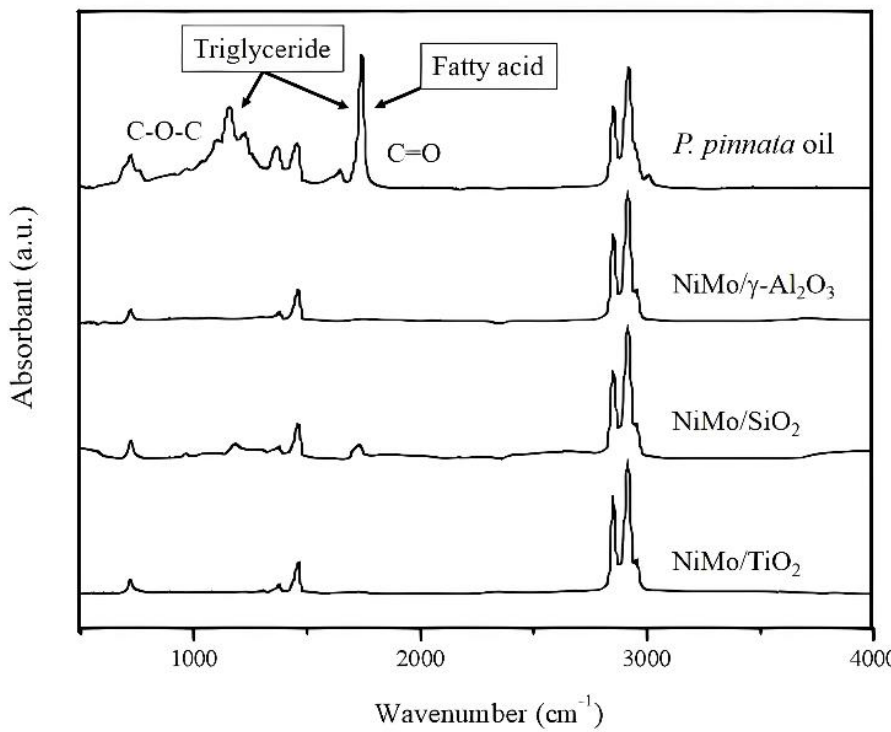
Figure 8. The FTIR spectra of Pongamia pinnata seed extracted oil and deoxygenated liquid product over NiMo/ γ -Al 2 O 3 , NiMo/SiO 2 , and NiMo/TiO 2 . All experiments were conducted at a temperature of 330 ◦ C, H 2 pressure of 50 bar, WHSV of 1.5 h − 1 , and H 2 /oil ratio of 1000 cm 3 /cm 3 . The product was collected after stabilizing the reaction for 9 h.